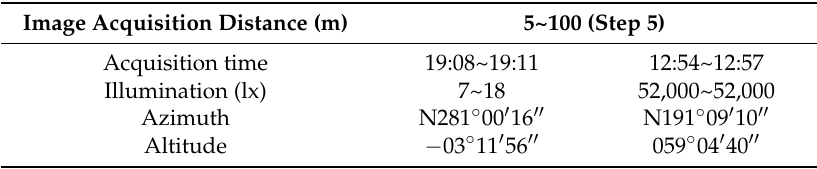
Table 1. Environmental conditions for crack specimen image acquisition experiment.